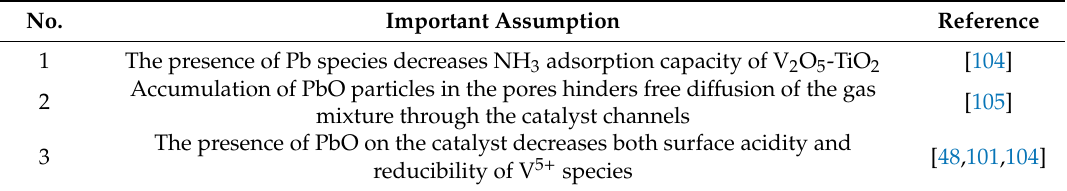
Figure 3. Deactivation mechanism of V-OH species by PbCl 2 (based on [103]). Table 5. The most important findings on the interaction of lead with V 2 O 5 -TiO 2